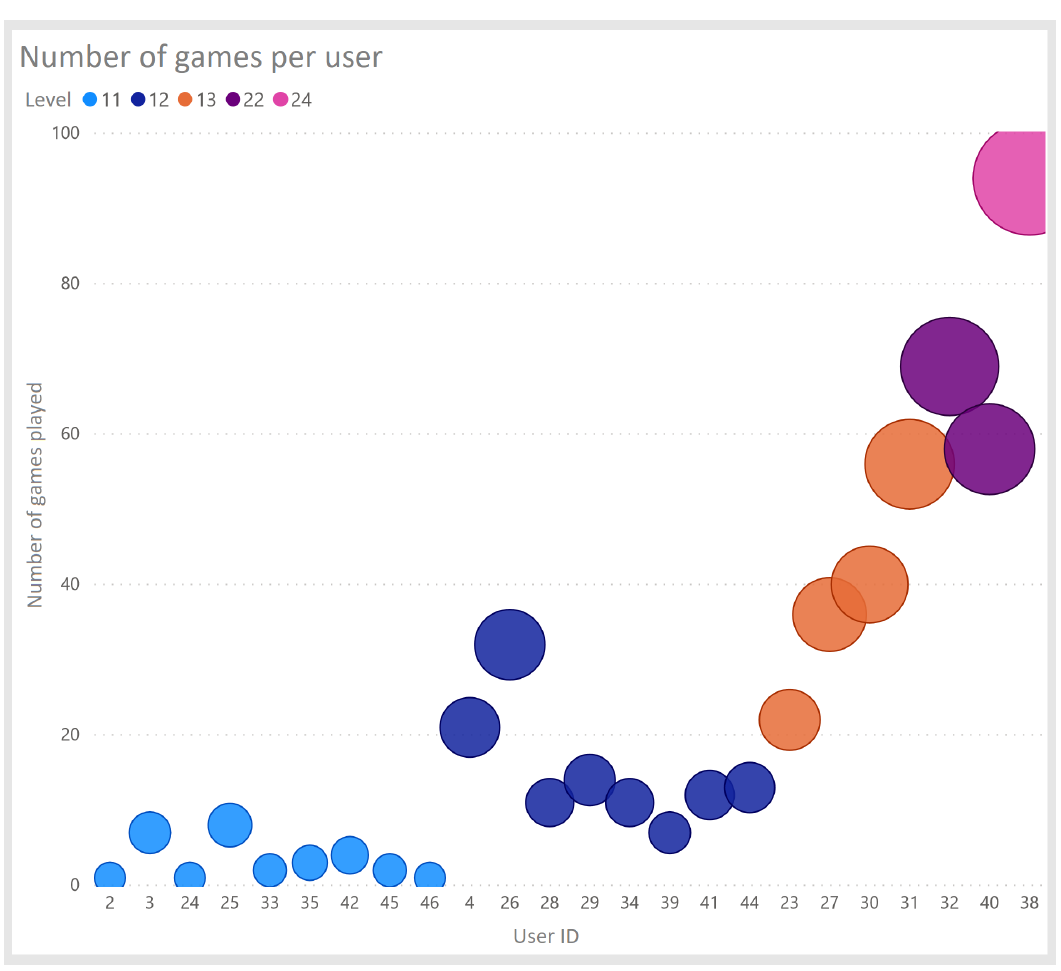
Figure 9. The frequency of application’s use, sorted by the final achieved level of individual user. The circle color represents individual levels (11, 12, 13, 22, and 24), while its size shows the number of games played by the individual